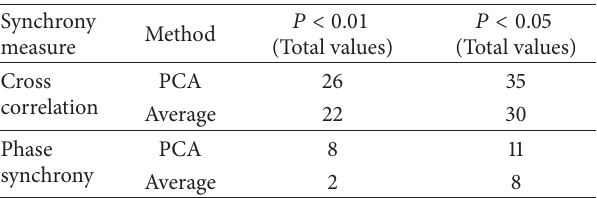
Table 2: Total number of significant values in case of PCA and Average